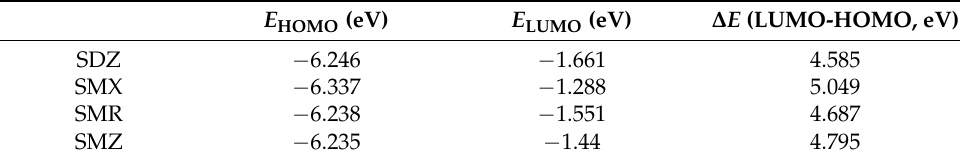
Table 3. HOMO and LUMO distributions of SAs calculated at the B3LYP/6-31+G ** level of theory.